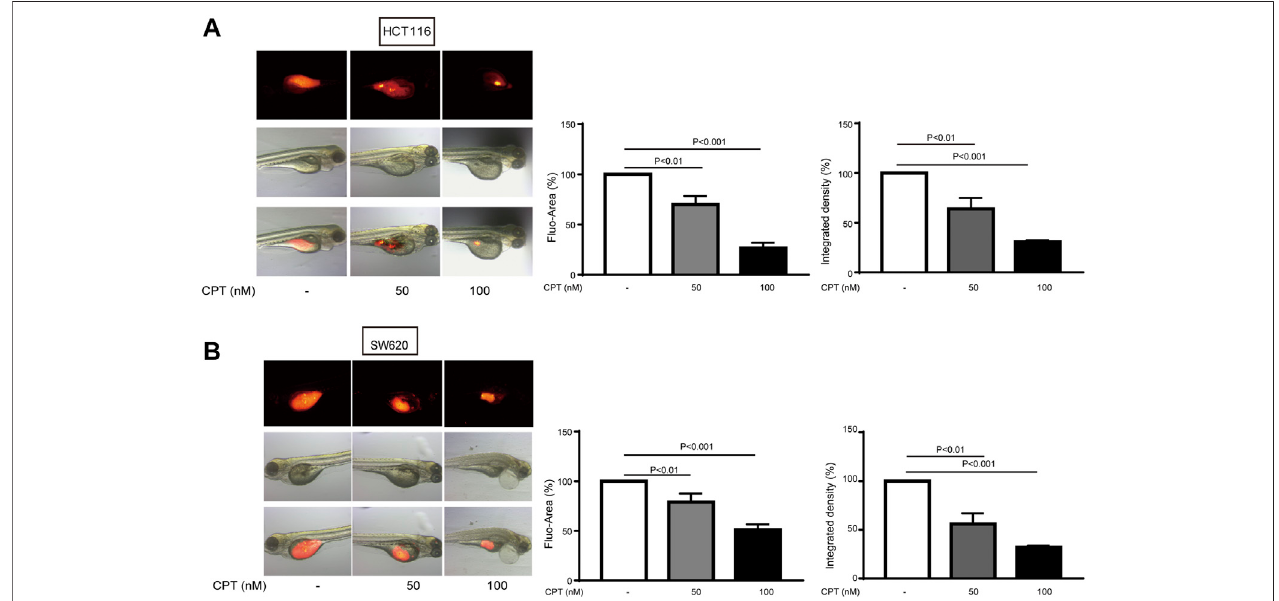
FIGURE 2 | The inhibitory effects of different concentrations of CPT on tumor growth of HCT116 and SW620 zebra fi sh models were determined. The inhibitory effects of different concentrations of CPT on tumor growth of HCT116 and SW620 zebra fi sh were determined. The tumor was indicated by red fl uorescence (A) , calculated as a percentage of the control value ( n (cid:2) 8) (B) . CPT,